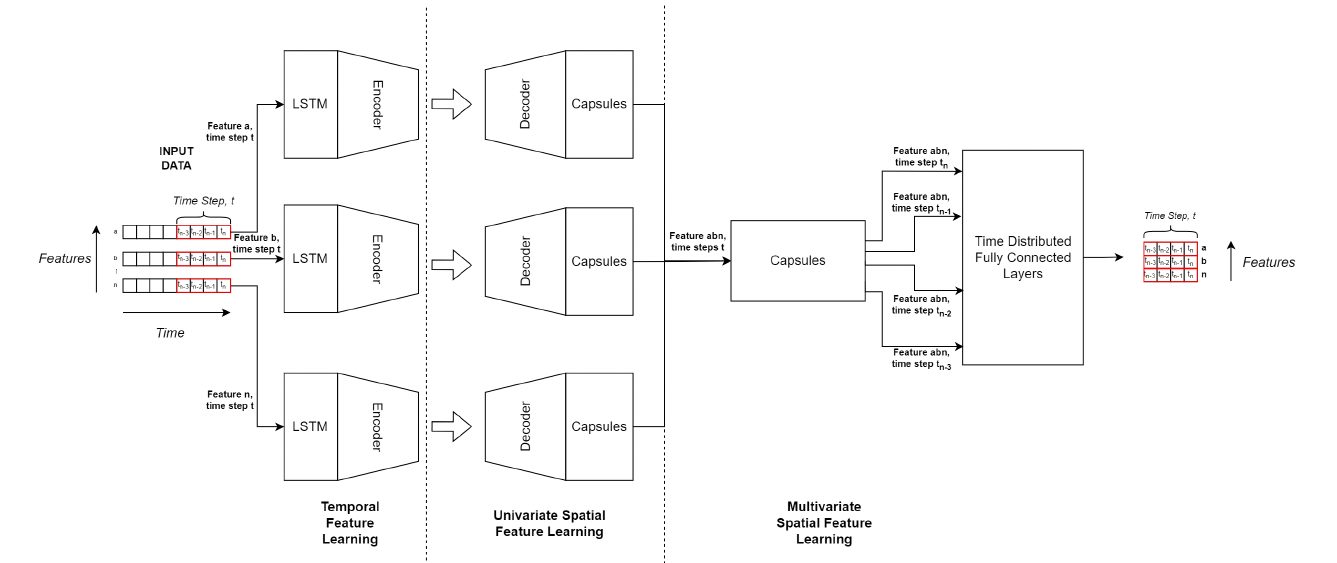
Figure 3. Proposed model